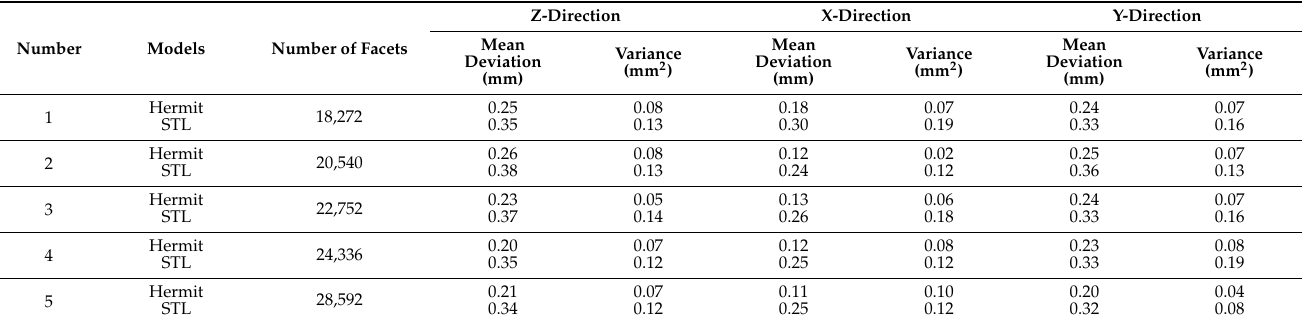
Figure 14. Sampling point acquisition for turbine model: ( a ) CAD model; ( b ) grid division; ( c ) sam- pling data points. Figure 15. Variation in mean deviation: ( a ) Z-direction; ( b ) X-direction; ( c ) Y-direction. Table 5. Fi tt ing error results after removing the “noise” from the turbine model.